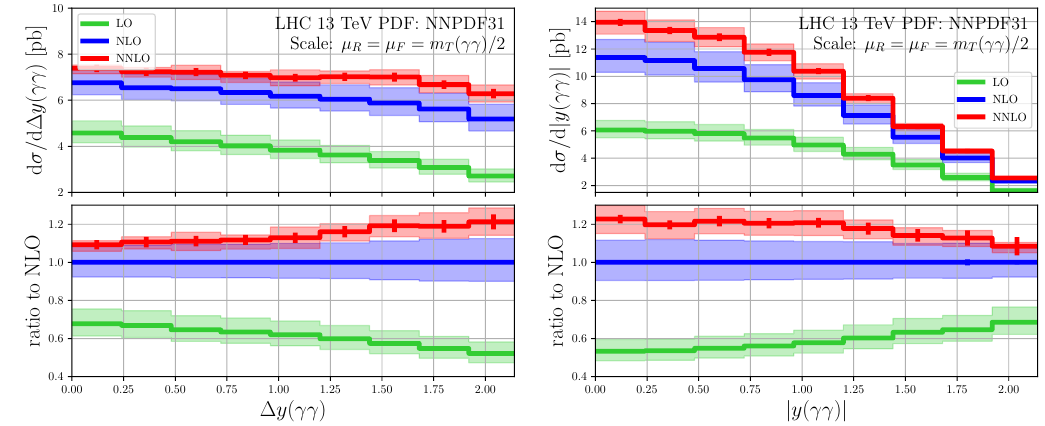
As in figure 1 but for the following rapidity distributions: ∆ y ( γγ ) (left) and | y ( γγ ) |